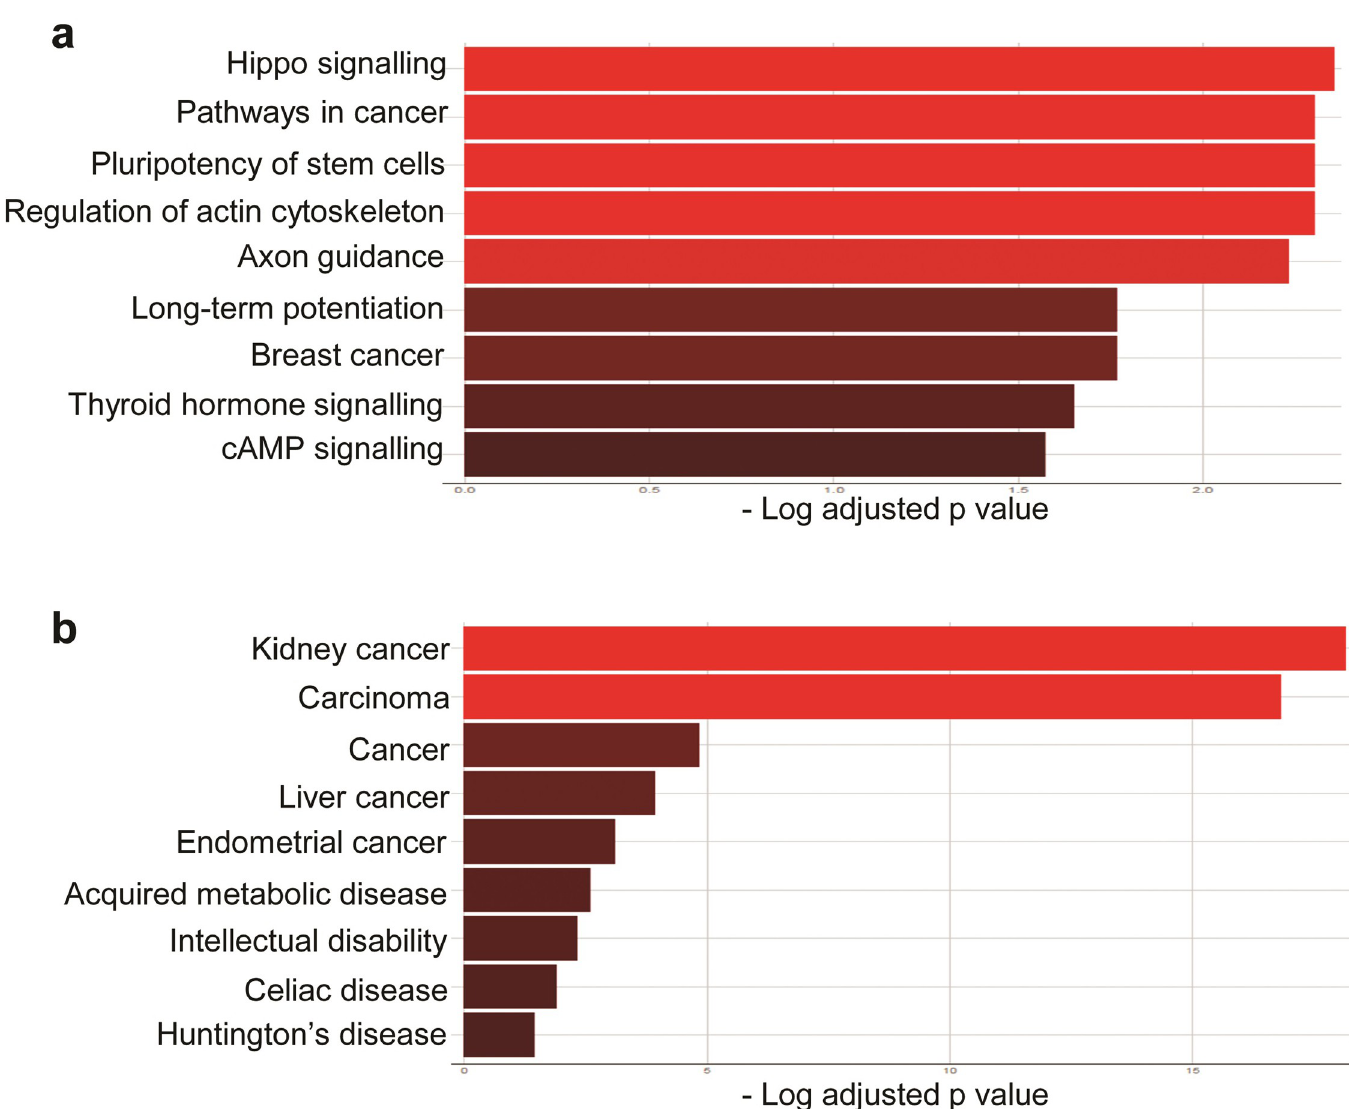
Fig 6. Potential biological processes regulated by miR-206 and miR-381. ( a ). Enrichr-based KEGG analysis of genes predicted to be co-targeted by miR-206 and miR- 381. ( b ). The JENSEN Disease analysis of genes potentially co-regulated by miR-381 and miR-206. For both analyzes, the predicted gene targets of these miRNAs were obtained using